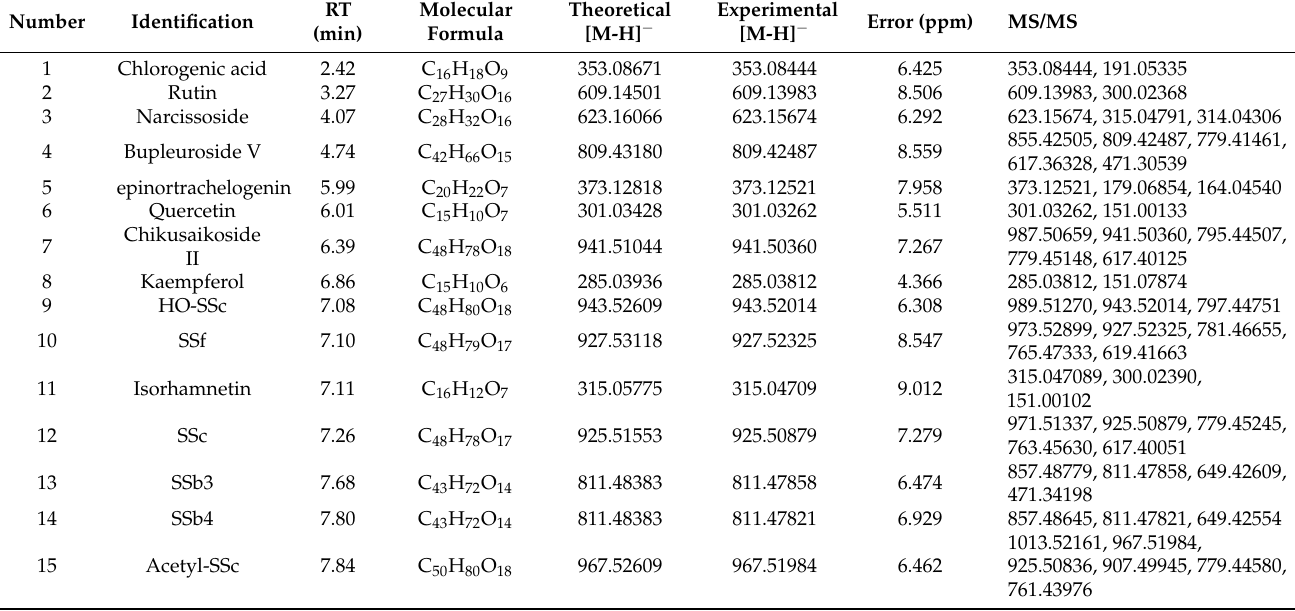
Figure 1. The representative total ion flow chromatograms of BC ( a ), VBC ( b ), and QC ( c ). Table 1. Chromatographic retention time and mass spectrum information of the identified com- pounds.